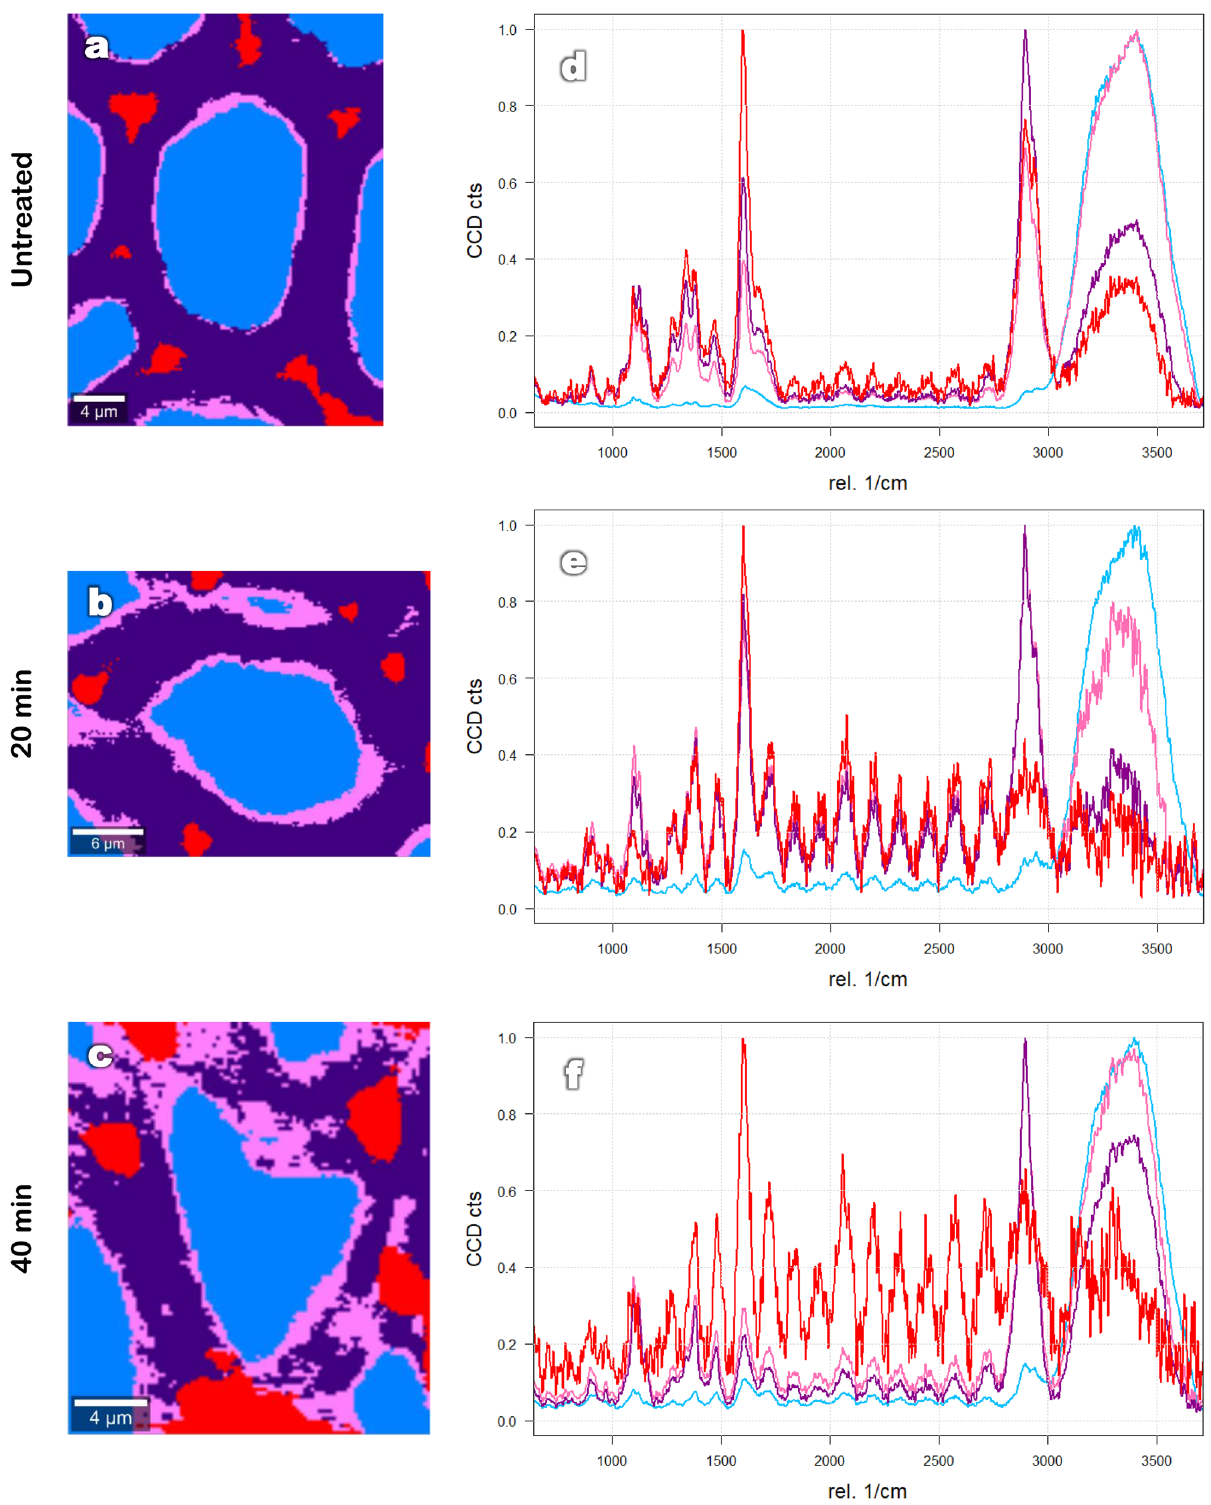
Figure 2. Raman images of untreated ( a ) and hydrothermally treated (160 °C) poplar samples based on hierarchical cluster analysis ( b , c ) and the average spectra of respective clusters (normalized) ( d , f ). [Images ( a – c ) were obtained with the help of Project FOUR software